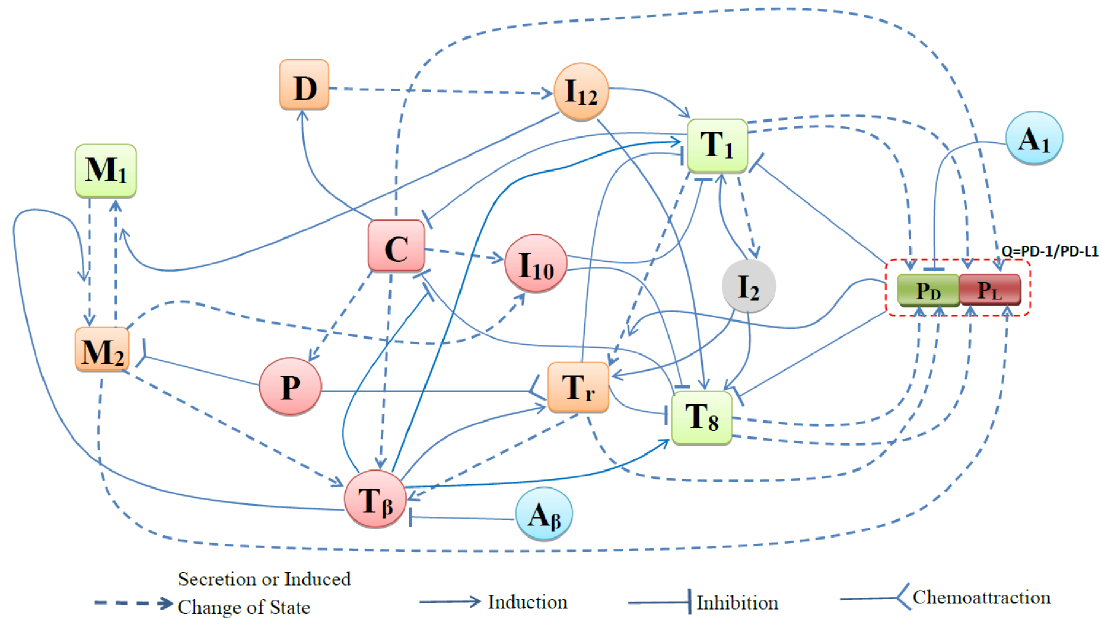
Fig 1. Network describing the interactions between cells and cytokines under treatment with anti-PD-1 and anti-TGF- β .